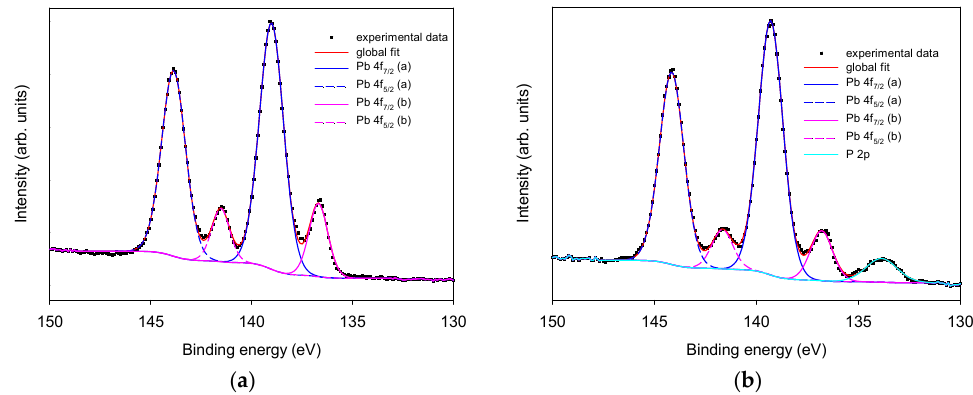
Figure 4. XPS high-resolution region of Pb and P 2p. Panel ( a ): untreated Pt SPE; panel ( b ): phosphate buffer 0.1 M LIFT treated Pt SPE.